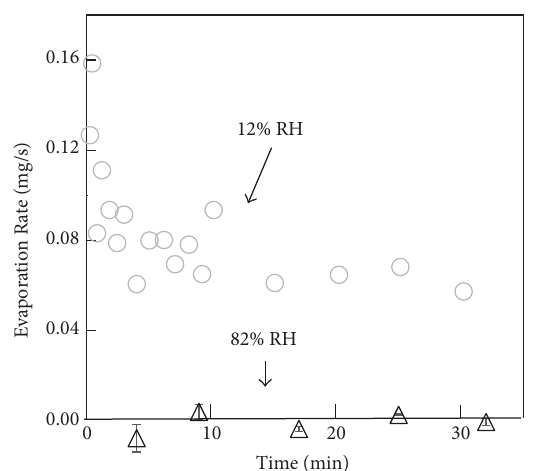
Figure 4: Evaporation rates of synthetic porewater [30] under open lab conditions (12% RH) and in a humidity chamber (82%